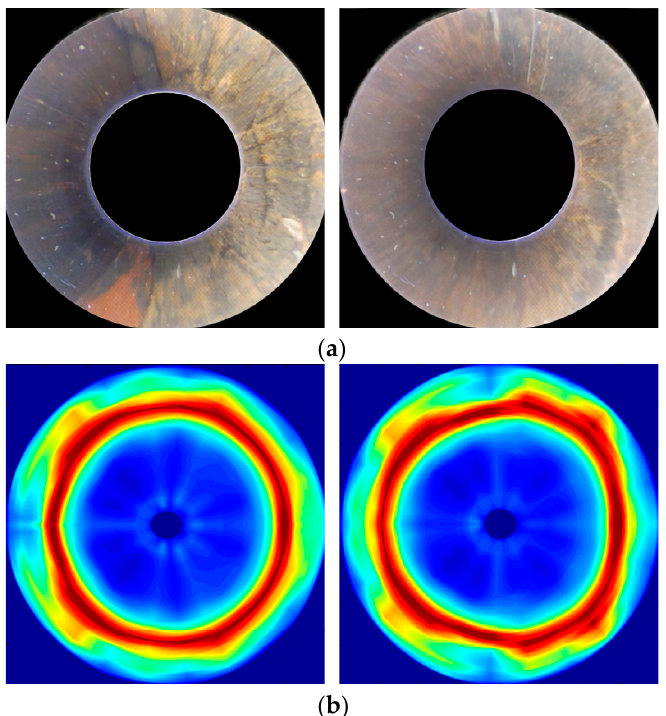
Figure 8. Partial data collected. ( a ) Video image screenshot of rock wall, ( b ) rock wall acoustic wave scanning data.